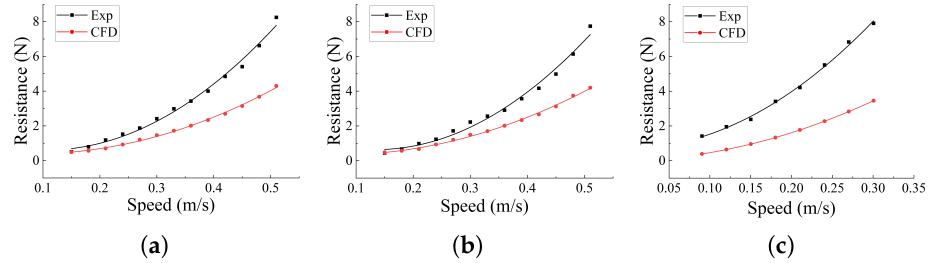
Figure 22. Resistance comparison of the underwater vehicle obtained by the CFD simulations and the physical experiment platform. ( a ) Resistance comparison along positive x -direction; ( b ) resistance comparison along negative x -direction; and ( c ) resistance comparison along y